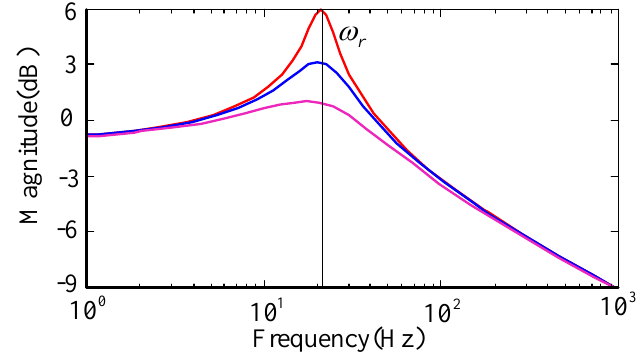
Figure 3. Magnitude response of